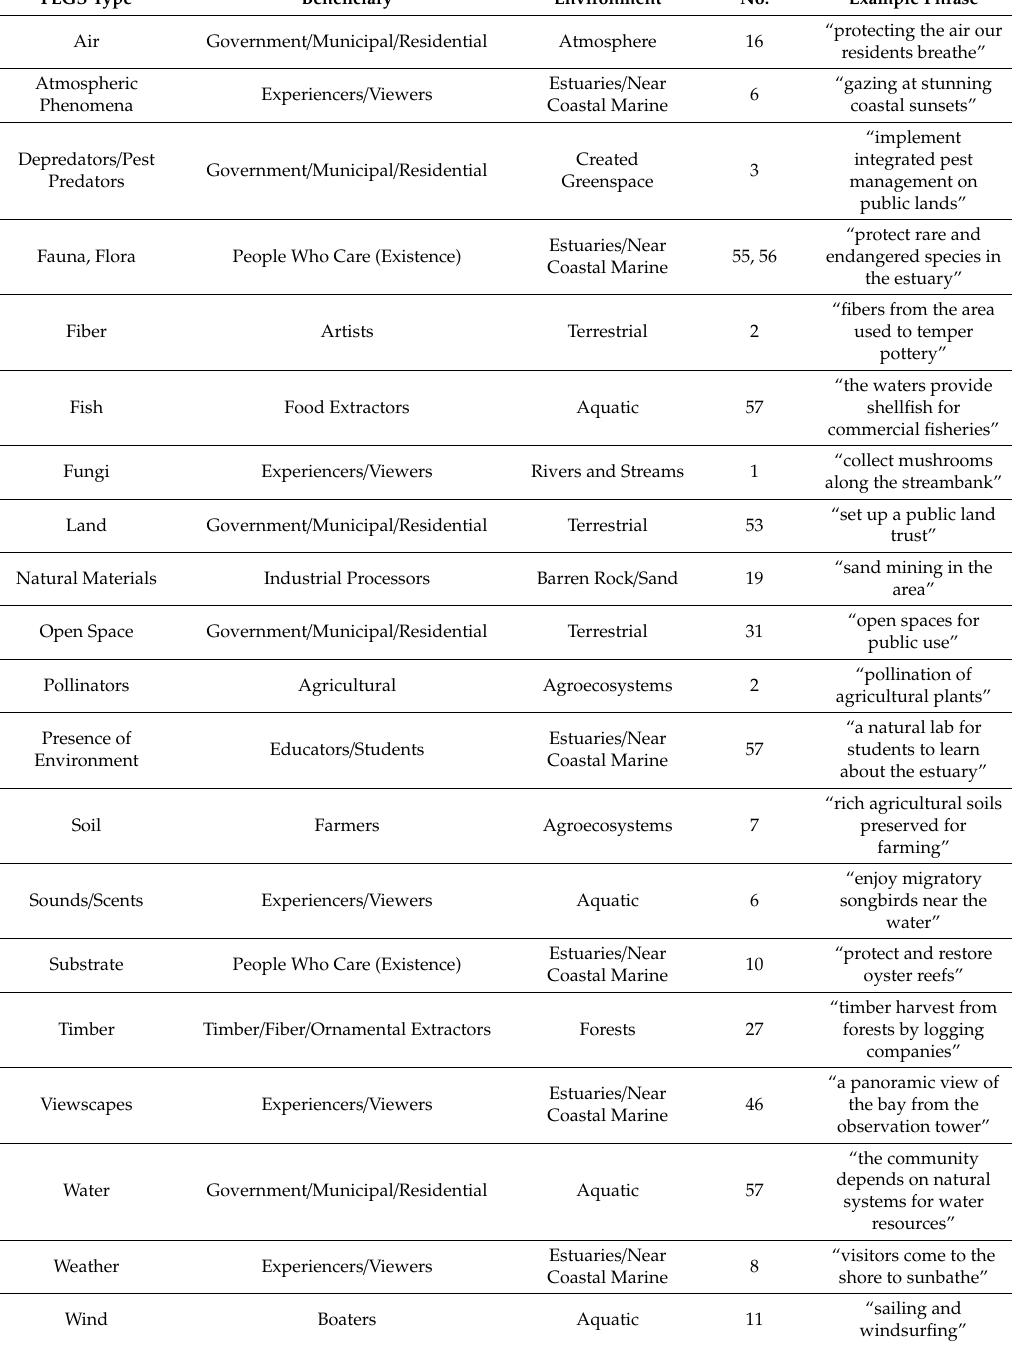
Table 6. List of the most common Beneficiary and Environment Classes associated with each type of FEGS,outof1614identifiedcombinations,